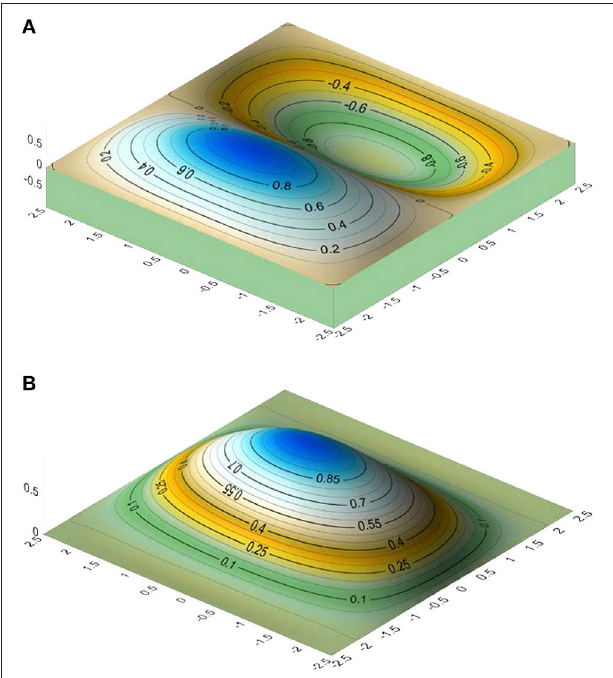
FIGURE 5 | (A) 1st vibration mode of the shell in Example 1. (B) 2nd vibration mode of the shell in Example 1.